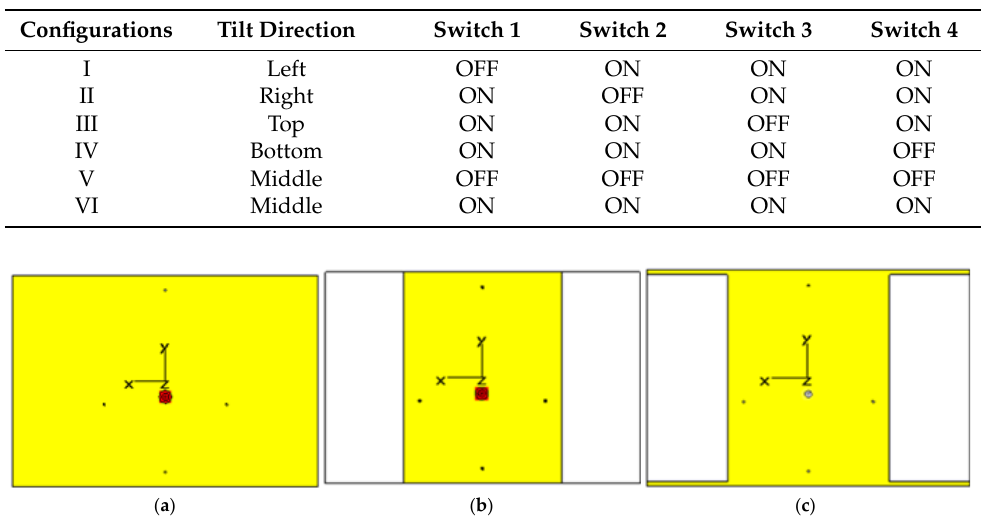
Table 1. Switching configurations of the proposed antenna.